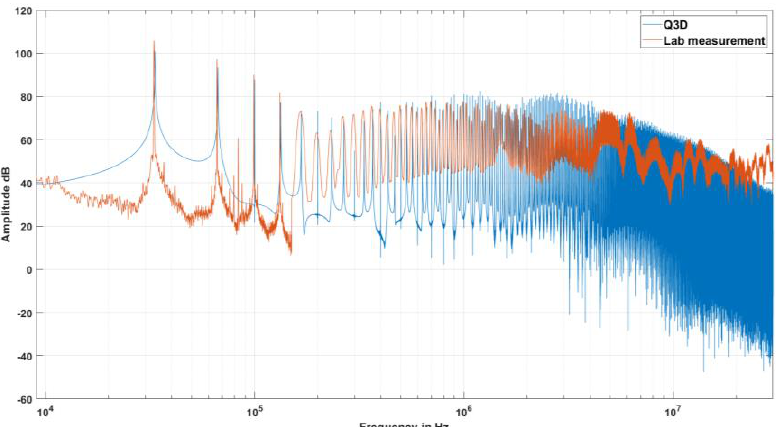
Figure 24. Comparison of PK measurement (orange) and estimation (blue) for the HFSS approach. Frequency sweep 9 kHz to 30 MHz.